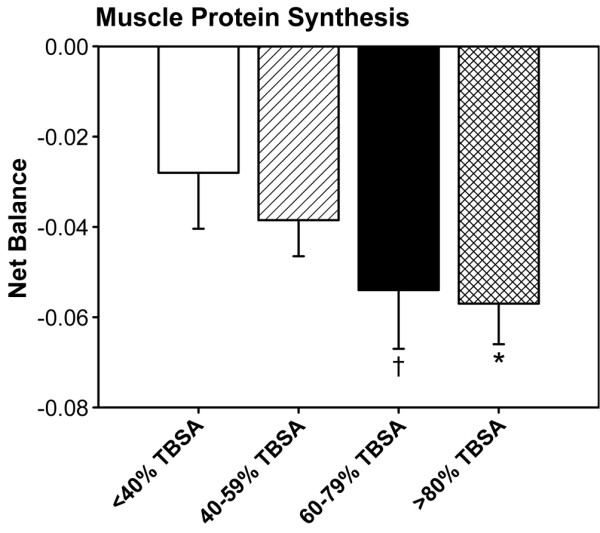
Peripheral muscle protein net balance during acute hospitalization. All burned children had a negative net protein balance in skeletal muscle. The greatest muscle protein loss was found in children with 60–79% and >80% total body surface area (TBSA) burn. *Significant difference between >80% TBSA burn group versus <40% TBSA burn group, P < 0.05.